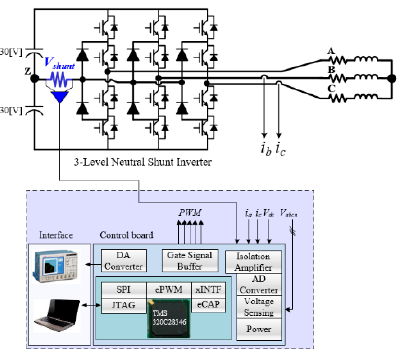
Figure 23. Configuration of hardware system and control board.